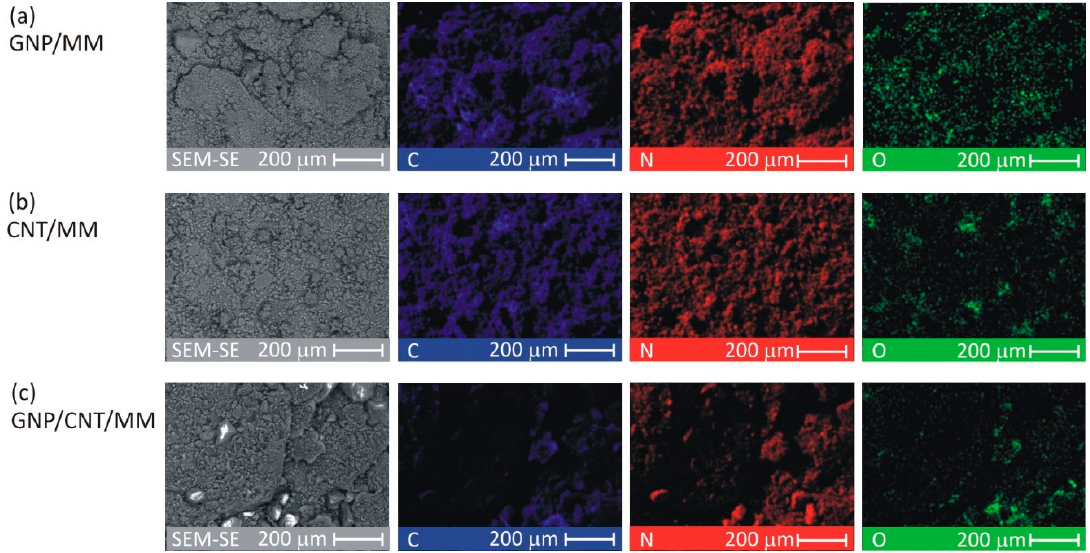
Figure 2. SEM-EDS images of the as-prepared composite powders.